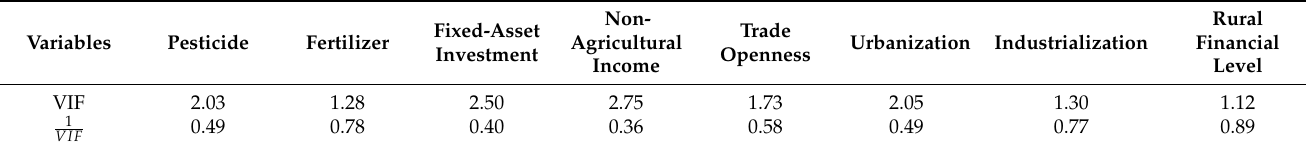
Table 3. The result of VIF